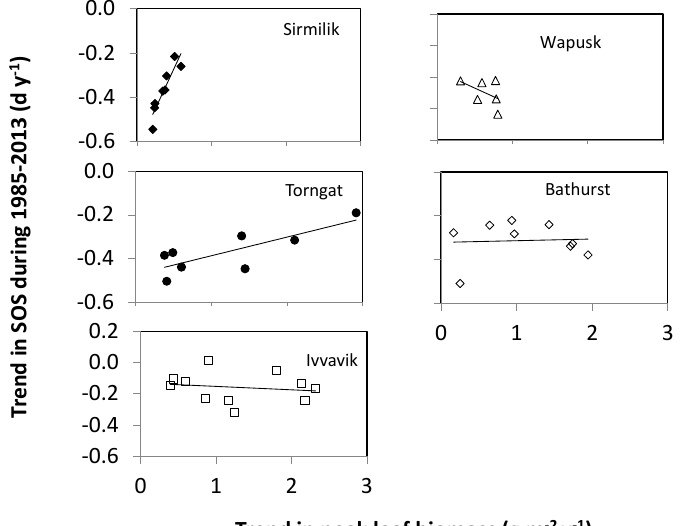
Figure 7. Relationships between trends in SOS and peak leaf biomass during 1985–2013 over all five study areas: Sirmilik ( R 2 = 0.84, p -value = 0.001, n = 8), the Torngat Mountains ( R 2 = 0.63, p -value = 0.018, n = 8), Ivvavik ( R 2 = 0.03, p -value = 0.64, n = 11), and Wapusk National Parks ( R 2 = 0.24, p -value = 0.33, n = 6), and the Bathurst caribou range ( R 2 = 0.003, p -value = 0.89, n = 9).